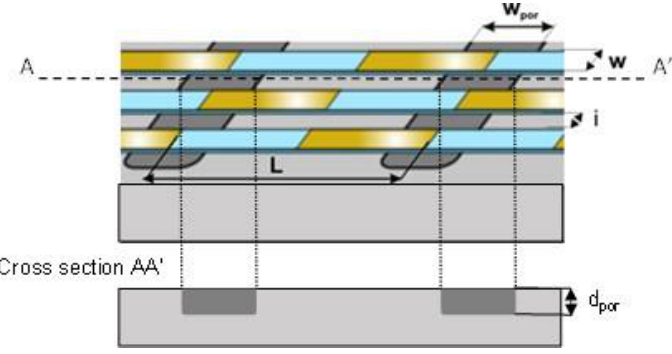
Figure 3. Zoom on an elementary cell of the heat flux microsensor.